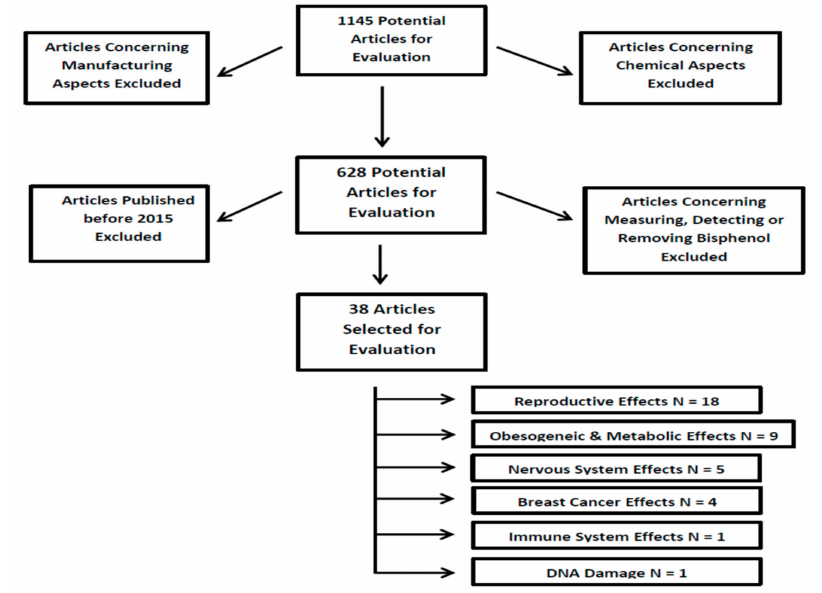
Figure 1. Flow chart of the article selection process. N = Population